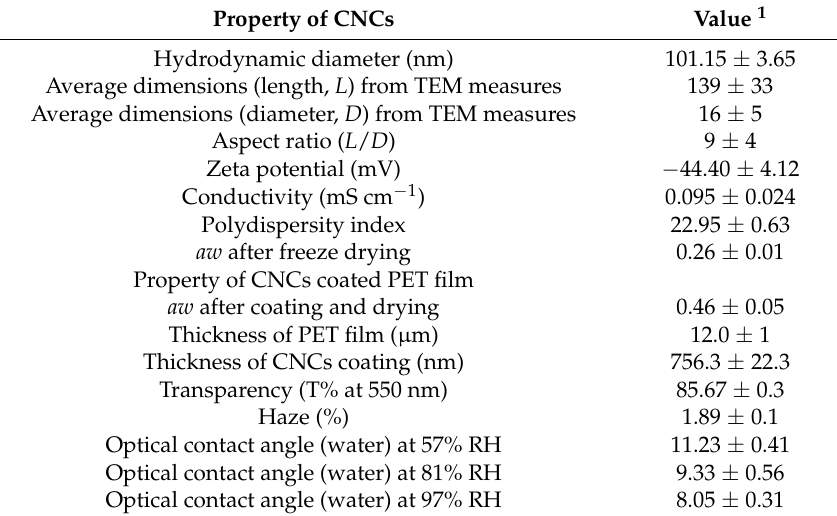
Table 1. Main characteristics of cellulose nanocrystals and of the CNCs coated PET film.